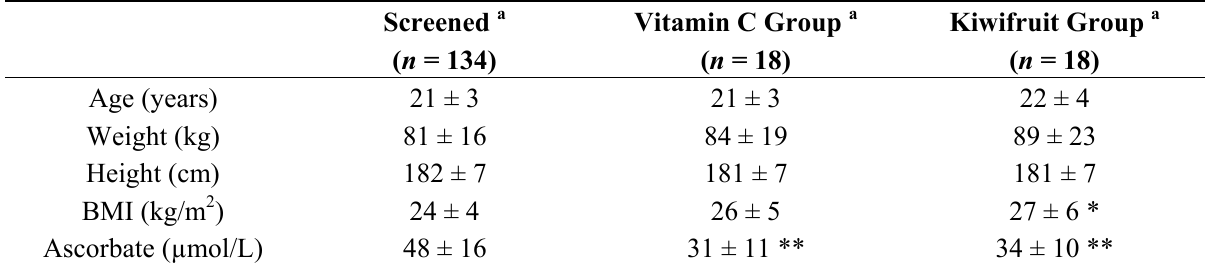
Table 1. Characteristics of individuals screened and enrolled in the study. Screened a